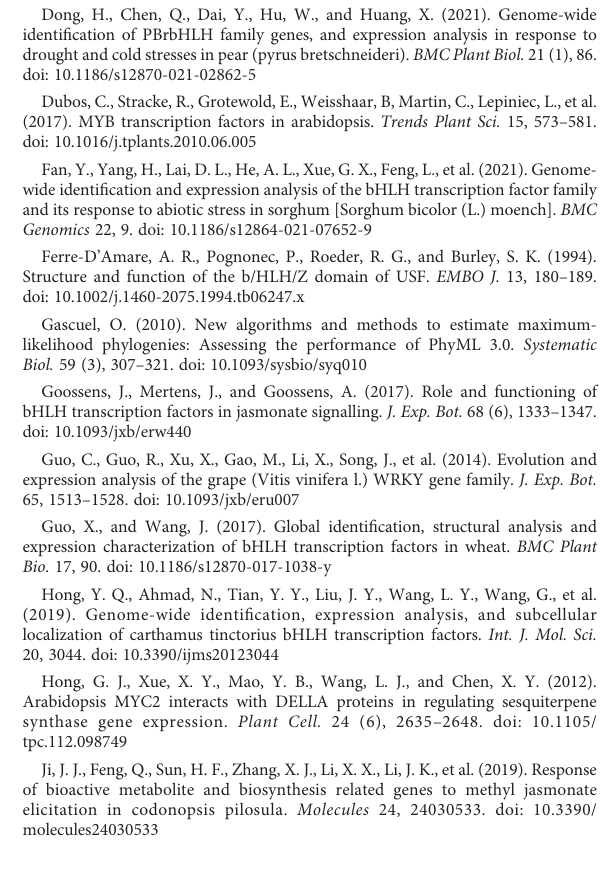
SUPPLEMENTARY FIGURE 1 Cis-element analysis of terpenoids synthesis pathway gene promoters in L. cubeba . The potential cis-regulatory elements in the promoter regions 2,000 bp upstream of the L. cubeba . were predicted by PlantTDFB